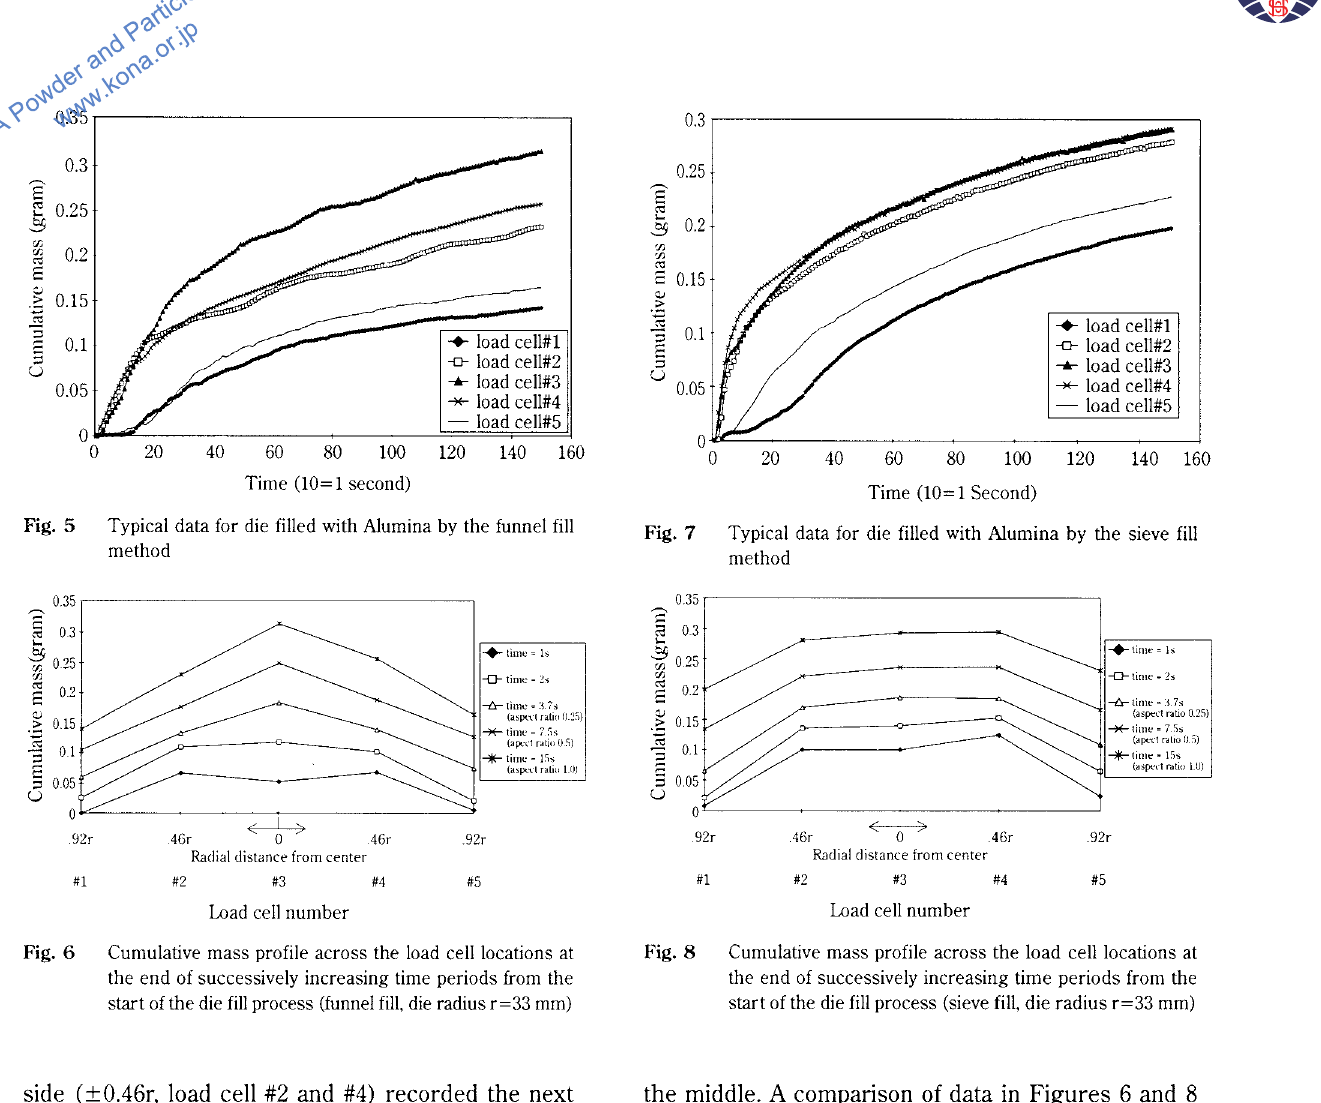
the middle. A comparison of data in Figures 6 and 8 shows that the load cells record a more flatter profile in the case of sieve fill than the funnel fill case. This suggests a more uniform powder fill for the sieve fill ing method compared to the funnel fill method.